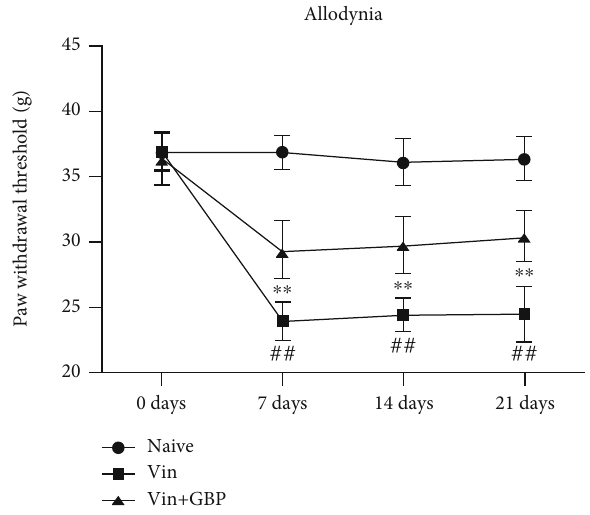
Figure 4: G. elata polysaccharide (GBP) treatment relieves pain hypersensitivity in vincristine-induced neuropathic pain rats. Paw withdrawal threshold in di ff erent groups. Data were expressed as the mean ± SD ( n = 8 for each group). # P < 0 : 01 : vs. naive group; ∗∗ P < 0 : 01 : vs. Vin group. Two-way ANOVA followed by Bonferroni ’ s post hoc